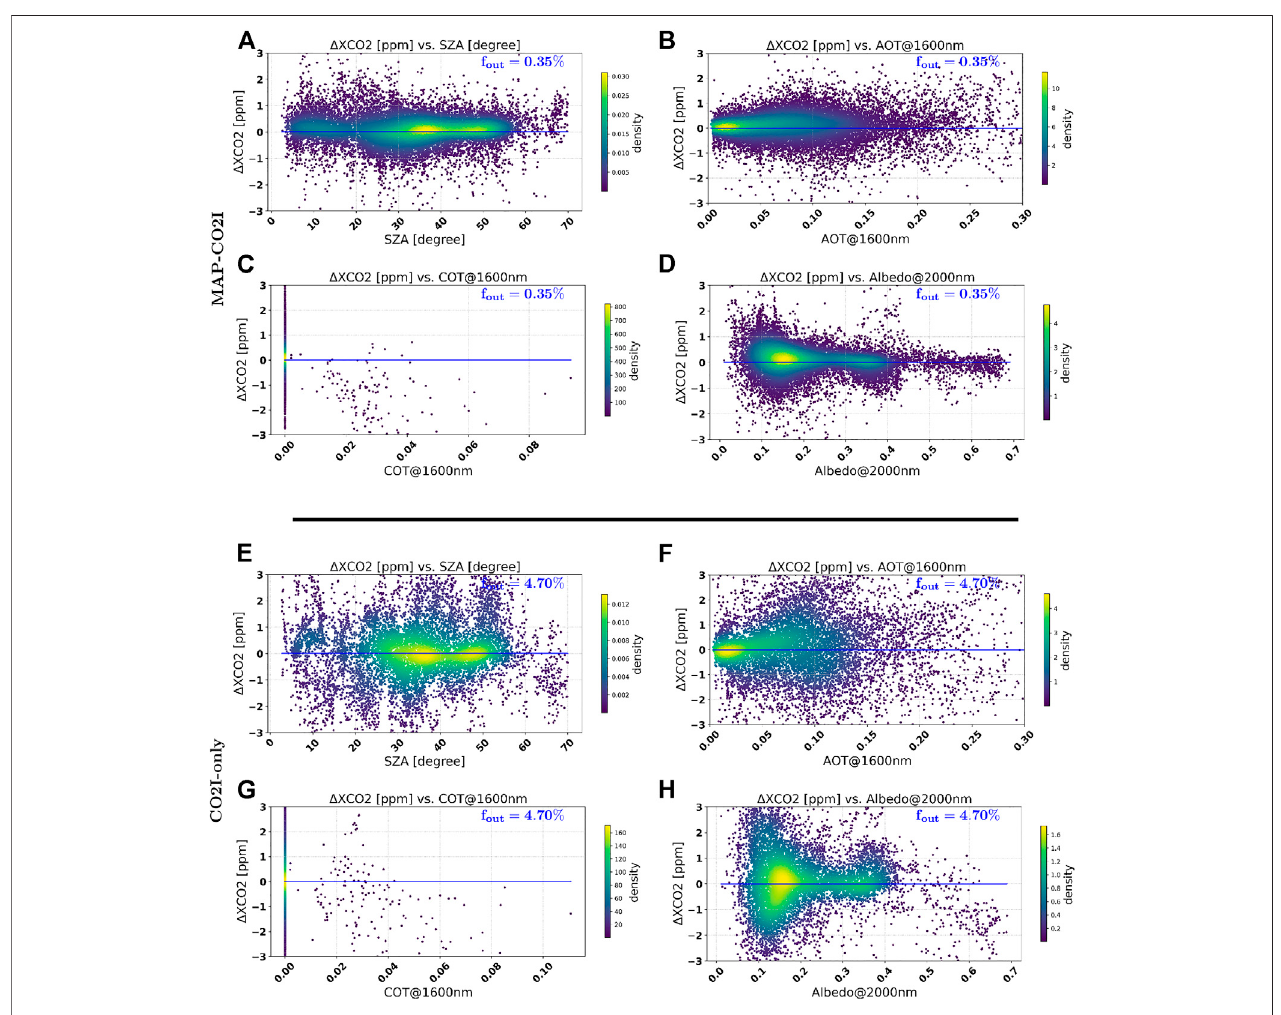
FIGURE6|(A – D) showtheerrorofMAP-CO2IretrievedXCO 2 asafunctionofsolarzenithangle(SZA),AOTat1600 nm,COTat1600 nmandBRDFscalingfactor at 2000 nm, respectively. (E – F) show th error of CO 2 I-only retrieved XCO 2 as a function of SZA, AOT, COT and BRDF scaling factor, respectively.